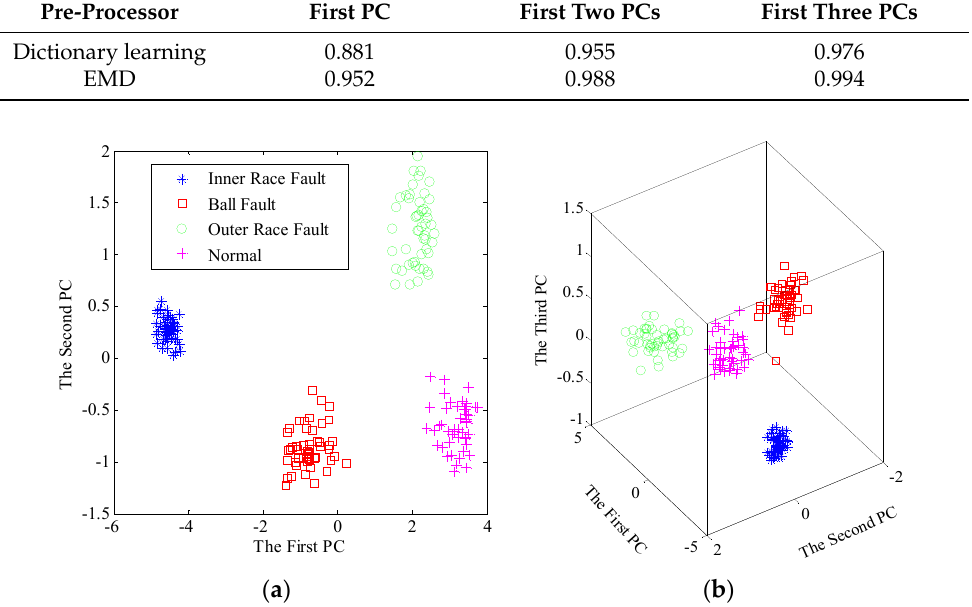
Table 2. Contribution rate of first few principal components in case 1.